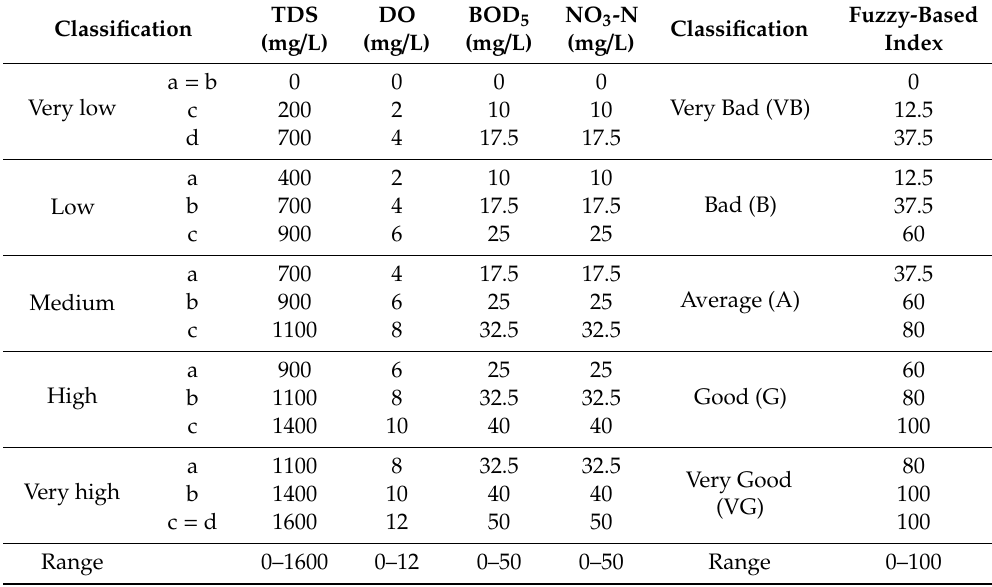
Table 2. Fuzzy sets and linguistic terms for the fuzzy-based